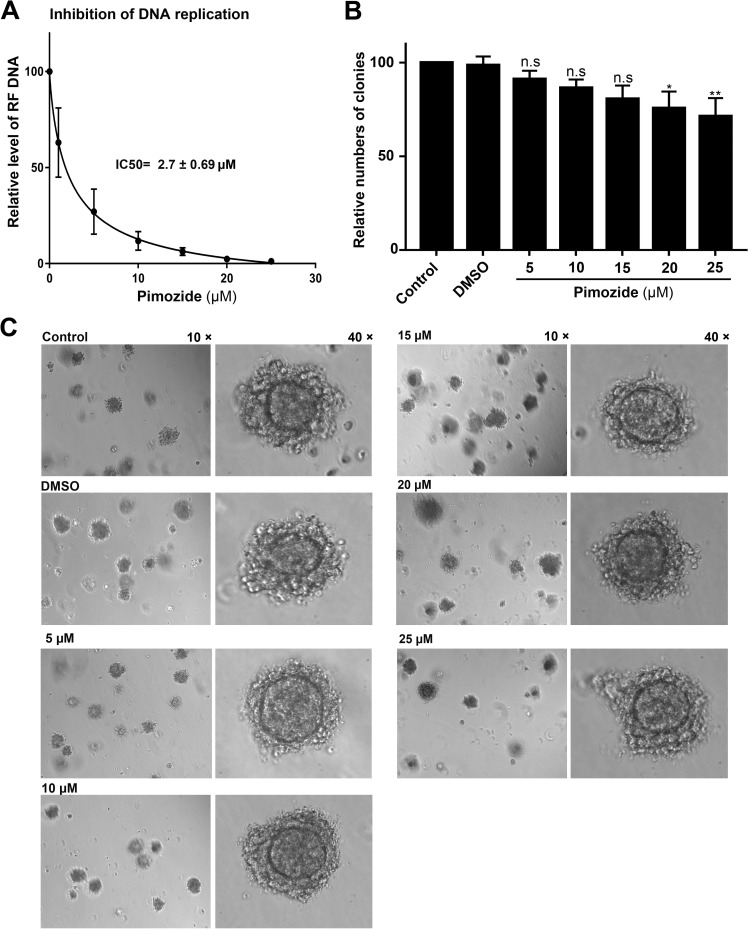
IC50 determination and colony formation assay.(A) IC50 determination. CD36+ EPCs incubated with pimozide at different concentrations were infected with B19V. After 48 h post-infection, the cells were extracted for Hirt DNA. The DNA samples were examined for B19V DNA with Southern blot analysis using a M20 RF DNA probe. Viral RF DNA was quantified. RF DNA levels with pimozide relative to levels without pimozide are plotted against the concentrations of pimozide for the calculation of the IC50 value with GraphPad Prism. (B&C) Colony formation assay. CD36+ EPCs were incubated with pimozide at different concentrations for 48 h, and then cultured in methyl cellulose-containing medium. After 10 days, numbers of the colonies were counted (B). P values are calculated using one-way ANOVA followed by Tukey-Kramer post-test, compared with DMSO group. ** P<0.01; * P< 0.05; n.s. (P>0.05) denotes no statistical significance. Images of colonies were taken with Eclipse C1 Plus (Nikon) inverted microscope at 10 × and 40 × magnifications (C).